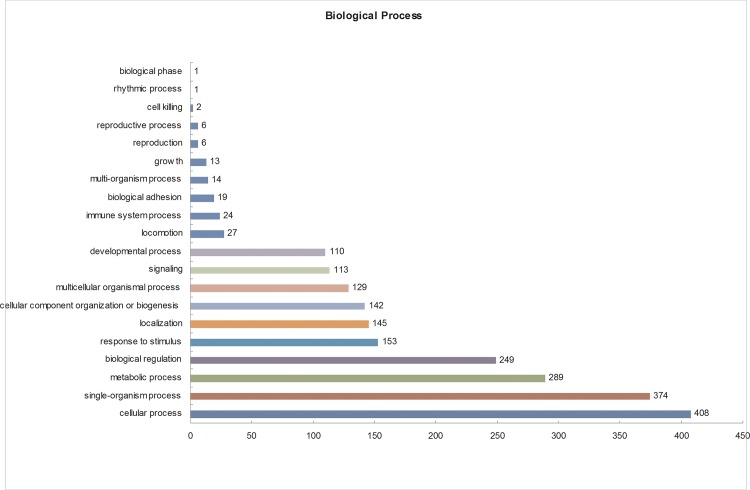
Gene Ontology (GO) biological process analysis of the differentially expressed proteins in the pituitary gland.All data are presented on the basis of GO second-level terms. Numbers refer to assigned proteins in each category.